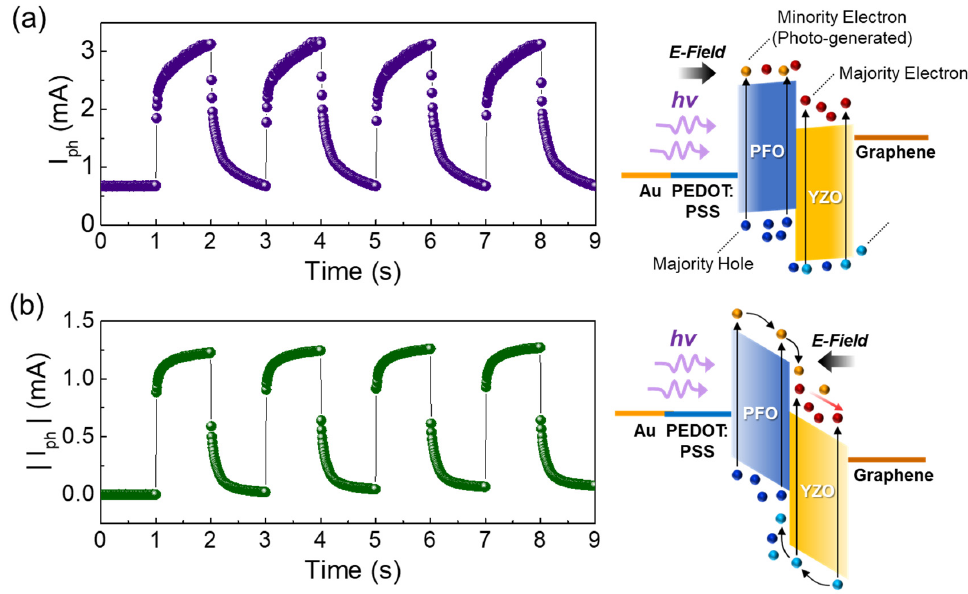
Figure 7. Photoresponse transient waveforms of the Y3 device under UV illumination (P opt = 0.6 mW / cm 2 ): ( a ) under forward bias at + 3.5 V and ( b ) under reverse bias at − 3.5 V. The right-hand-side insets of ( a ) and ( b ) represent the energy band diagrams and their corresponding photocarrier transport behaviors at forward and reverse bias states, respectively.